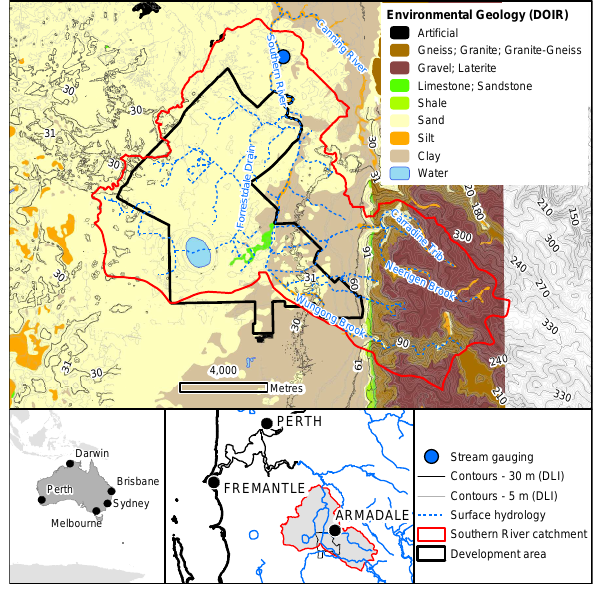
Figure 1. Location, topography and geology map Fig. 1. Location, topography and geology map.